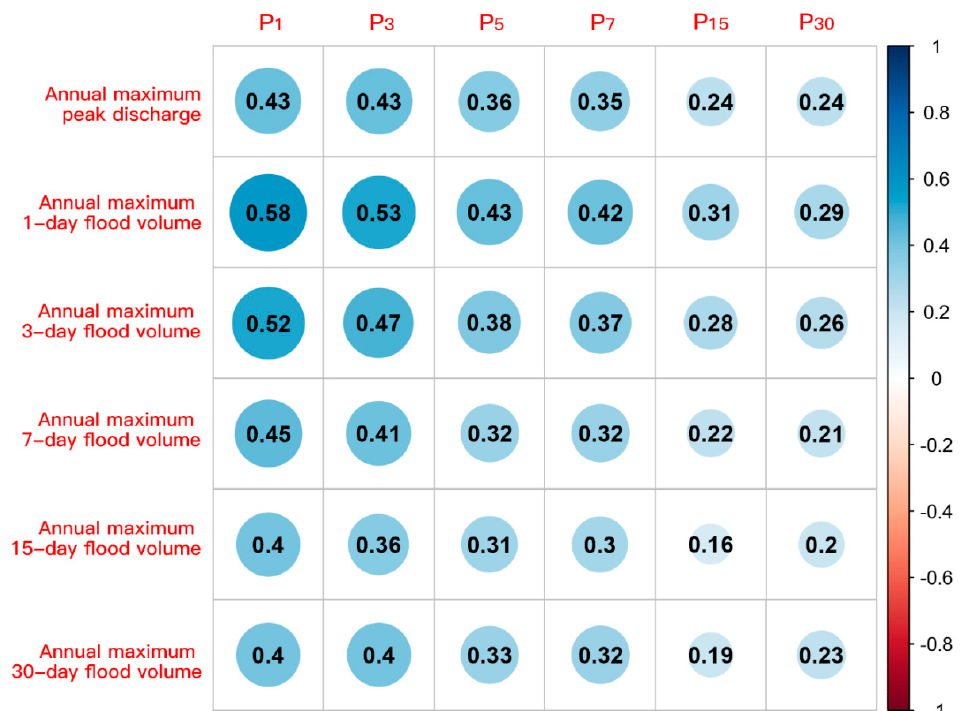
Figure 2. Spearman correlation between the rainfall series of different days before flood and the snowmelt flood characteristic series.